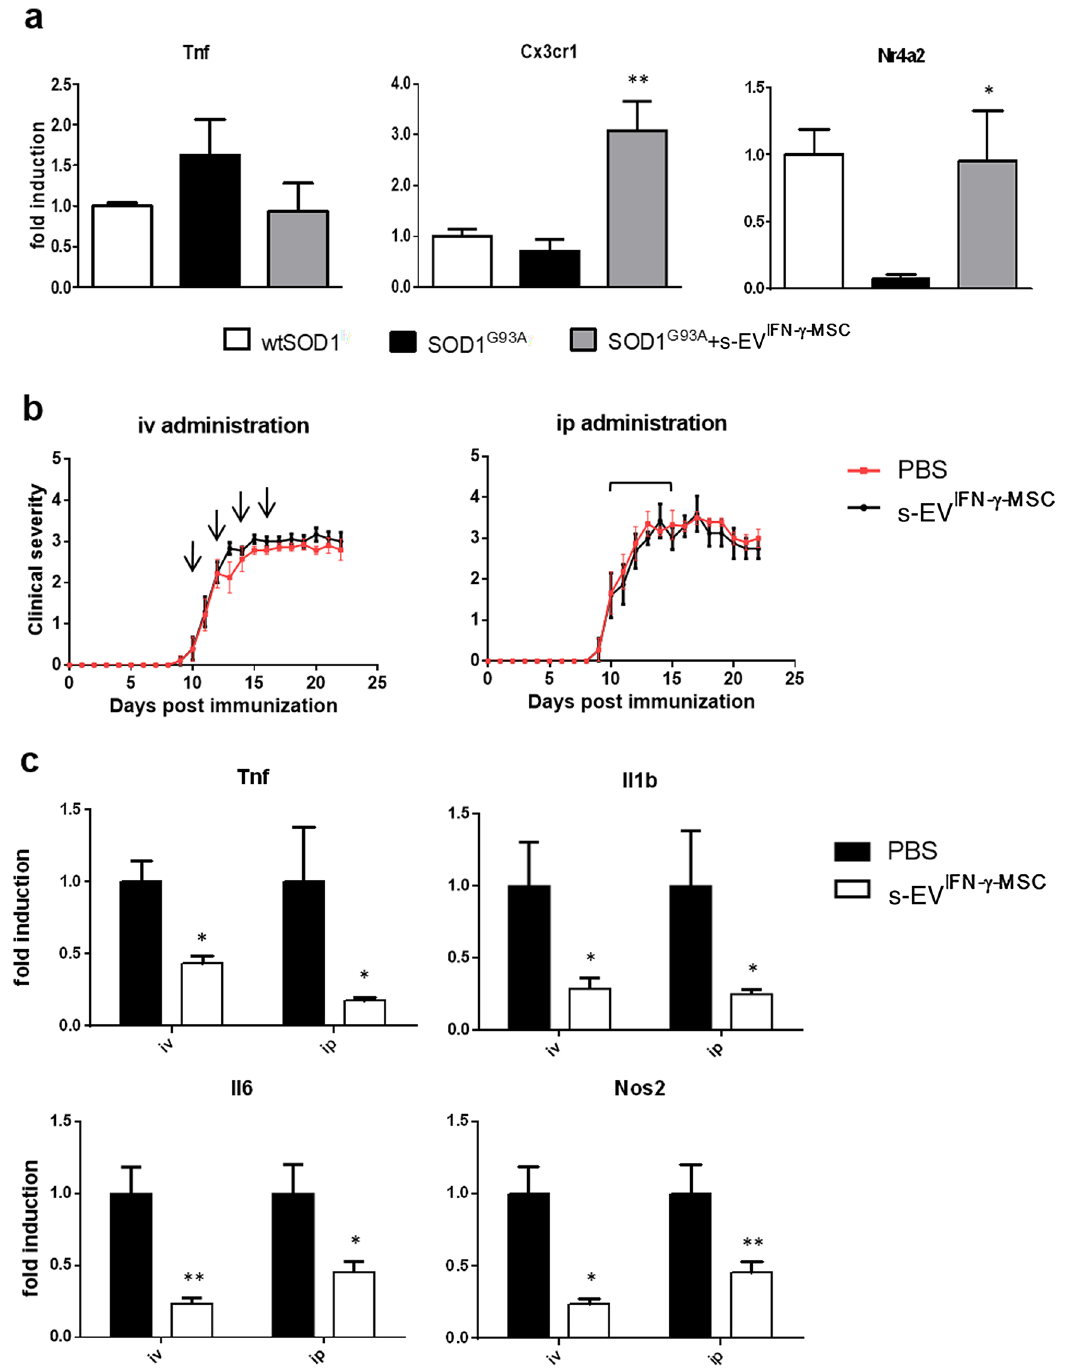
Figure 6. Exposure to s-EV IFN-γ-MSC downregulates neuroinflammation in neurodegenerative disease models in vitro and in vivo. ( a ) RT-PCR quantification of Tnf and genes associated with an anti-inflammatory/ neuroprotective phenotype (Cx3cr1, Nr4a2) in SOD1 G93A primary microglia, after a 24-h exposure to s-EV IFN-γ-MSC . Data are presented as mean ± SEM of 3 independent experiments conducted in triplicates. * P < 0.05 (Nr4a2), ** P < 0.01 (Cx3cr1): SOD1 G93A vs SOD1 G93A + s-EV IFN-γ-MSC . ( b ) C57BL/6 J mice induced for EAE were treated from the day of disease onset with s-EV administered intravenously or intraperitoneally (n = 8 per group). Data are presented as the mean ± SEM daily clinical score. Arrows represent the times of iv administration (left panel) and the line above the curve represents the daily ip administration (right panel). ( c ) RT-PCR analysis of pro-inflammatory markers (Tnf, Il1b, Il6 and Nos2) expression was assessed in spinal cords isolated at 20 dpi from EAE mice treated with s-EV IFN-γ-MSC or vehicle (at least n = 4 per group). Results are shown as mean ± SEM of 3 independent EAE experiments with n = at least 3 spinal cord tested per group. * P < 0.05, ** P <